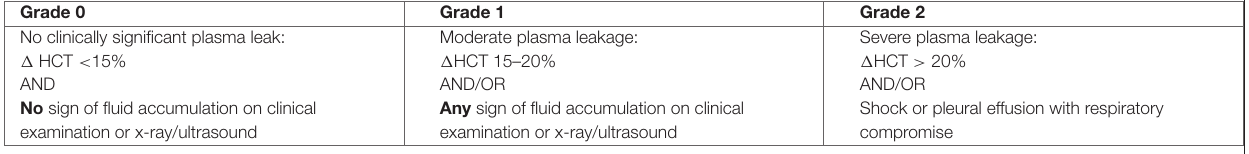
TABLE 1 | Characteristics at enrolment and clinical outcomes of patients included in this analysis.